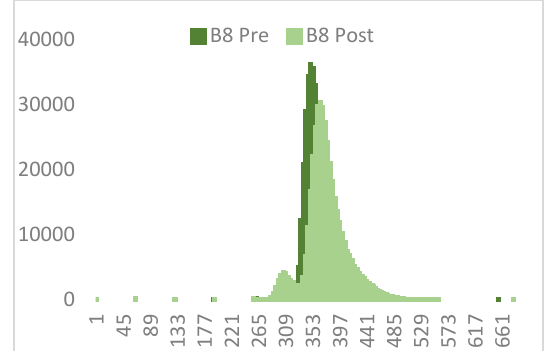
Figure 4 Histogram data plot for B8 before and after the fire event. The units on y-axes the frequency of the pixel